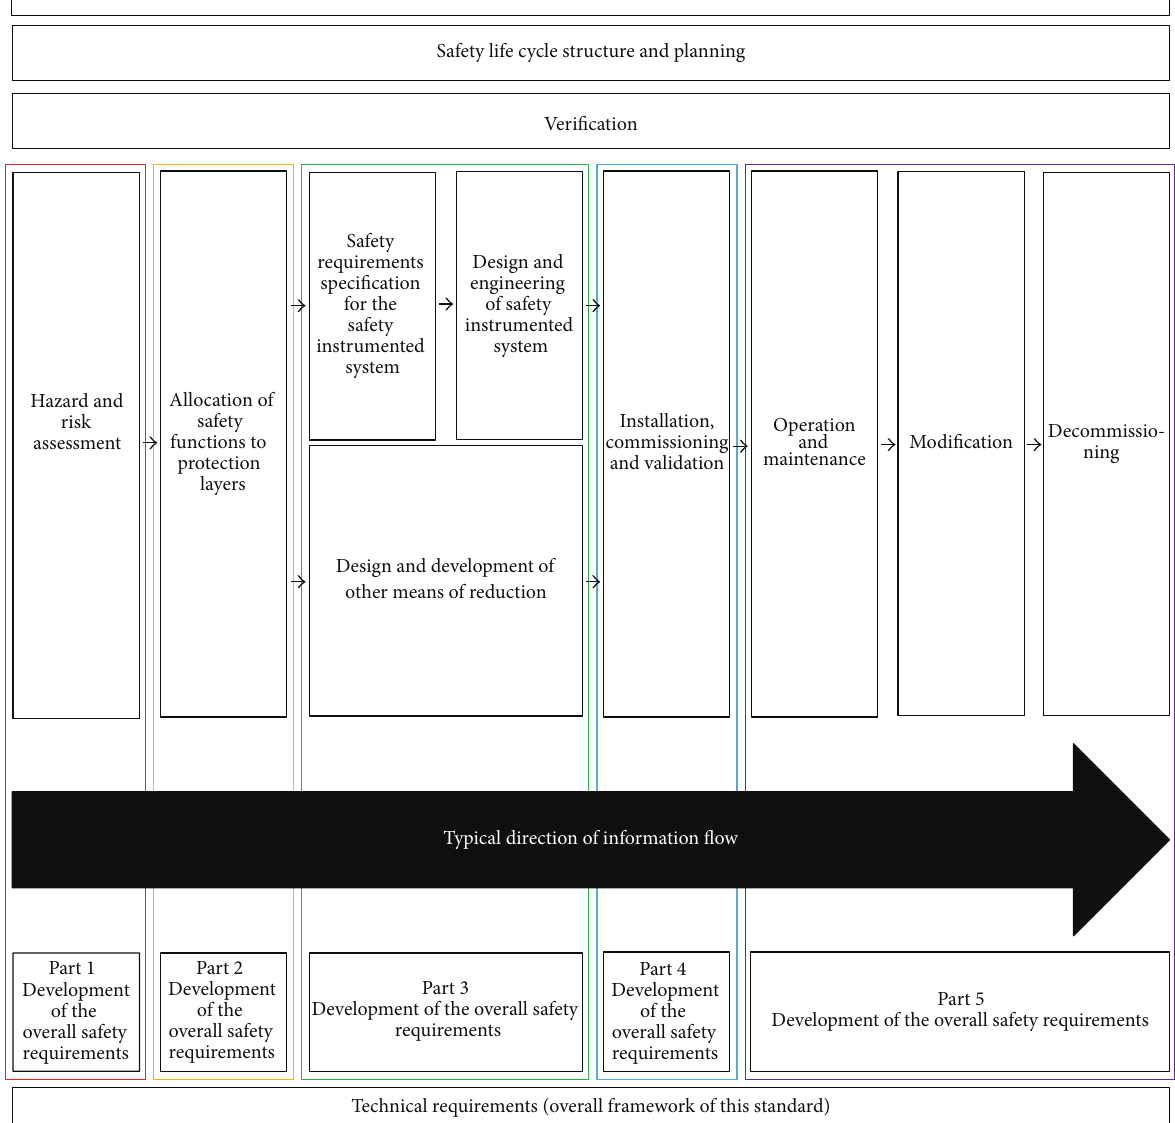
Figure 6: Overall framework of IEC